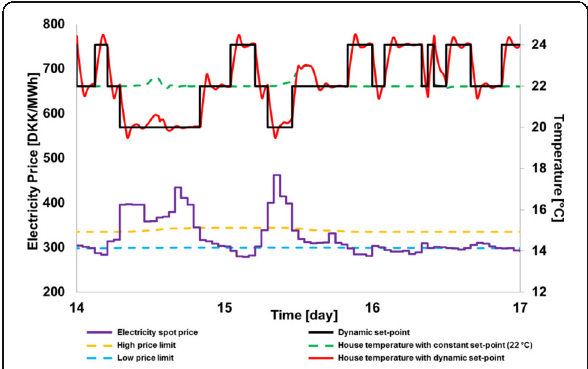
Fig. 8 (Abstract P8). An example of using the envelope of a building as a source of flexibility with simple rule-based setpoint control Hic18lg